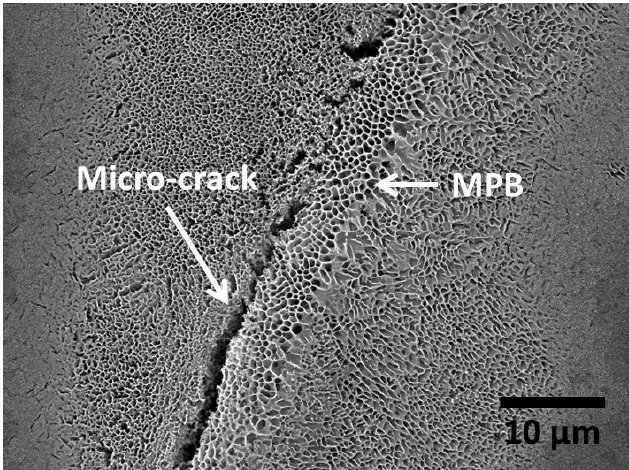
Figure 2. Secondary electron microscopy image of the surface of an as-built additive manufacturing (AM) Al-Si (AlSi10Mg) after immersion for 48 h in 0.1 M NaCl. The formation of micro-cracks in the heat affected zone next to the MPB can be seen. MPB—melt pool border.